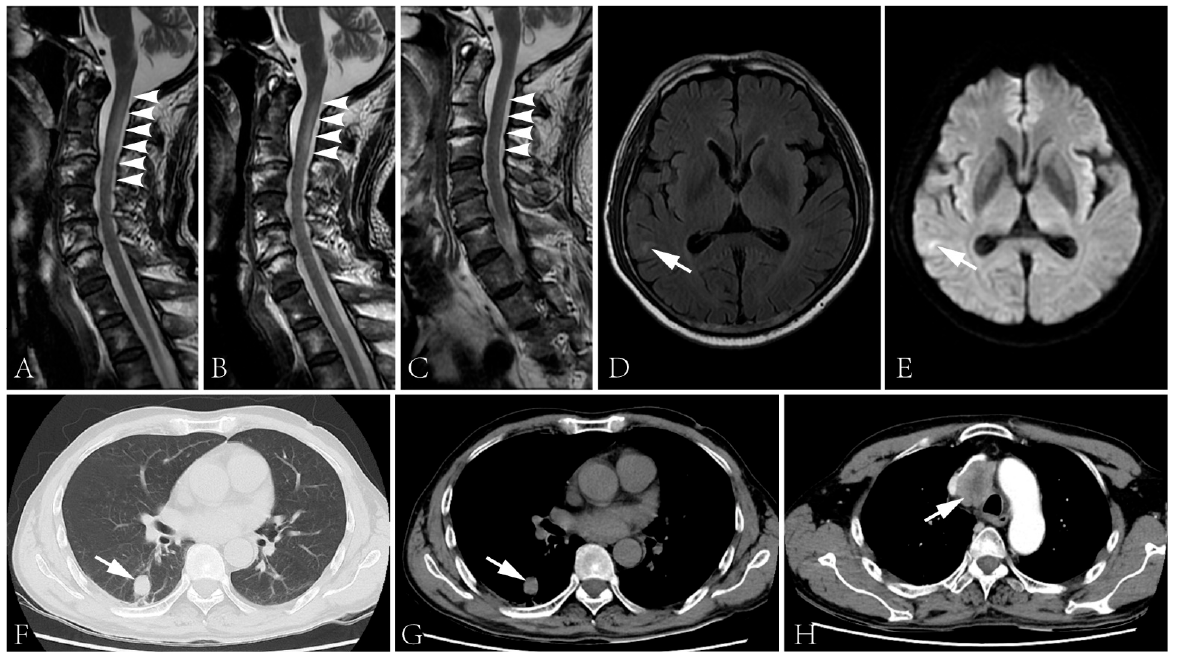
Figure 2. ( A – C ) Spinal cord MRI showed T2 signal abnormality in the cervical cord at fi rst admission ( A ), two days after the initiation of intravenous glucocorticoid ( B ) and second admission ( C ). The spinal cord lesion shortened after the administration of intravenous glucocorticoid and was merely visible during the second admission. ( D , E ) T2 fl air ( D ) and DWI ( E ) images of the brain showed right temporal lobe hyperintensity. ( F – H ) The CT scan showed a lung lesion ( F , G ) and a mass lesion with enhancement in the superior mediastinum ( H ).